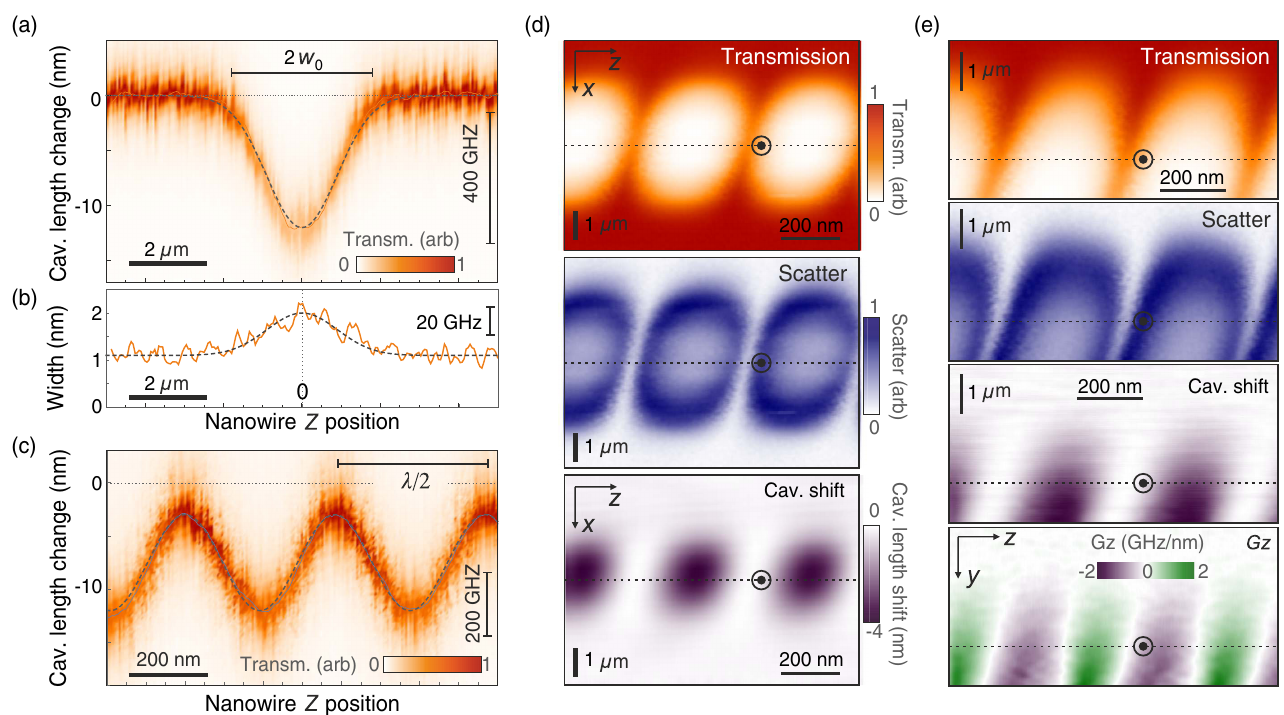
FIG. 2. Nanowire-based scanning probe exploration of the intracavity field. (a) Transmission stack of the cavity measured while scanning its total length with the slow piezo, in the vicinity of a TEM 00 mode and moving the nanowire across the optical mode ( x axis). The dashed line is a Gaussian fit of the measured resonance length shifts ( 1 . 8 - μ m waist). The change in linewidth is reported in (b). (c) Similar measurement realized while scanning the nanowire along the optical axis, revealing the standing-wave structure of the cavity mode. (d) Transmission and scatter maps measured when scanning the nanowire in the horizontal XZ plane while locking the cavity on resonance. The cavity-length shift map is obtained via the correction of the feedback loop, after substraction of the slow experimental drift. (e) Similar measurements obtained when scanning the nanowire in the vertical YZ plane ( X ¼ 0 ). The optical axis is marked with a dashed line. The parametric coupling strength G is obtained by spatial derivation of the cavity shift map along e z z